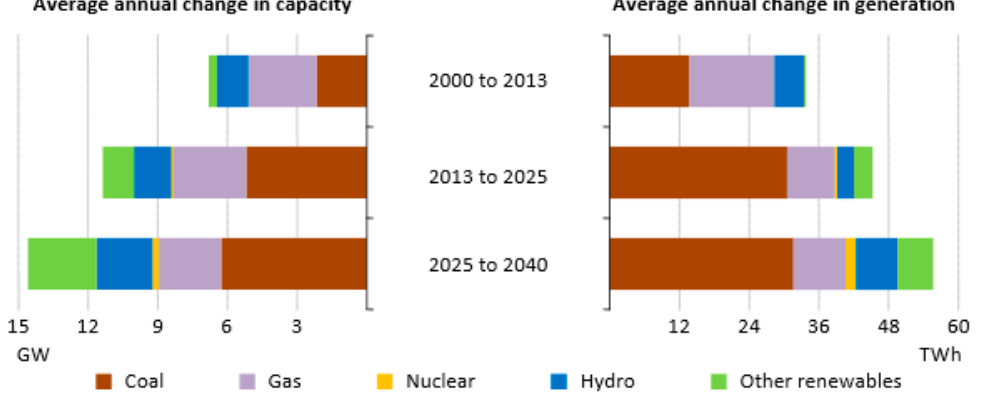
Figure 2. Average annual change in capacity and electricity generation in Southeast Asia ([39], p. 41).